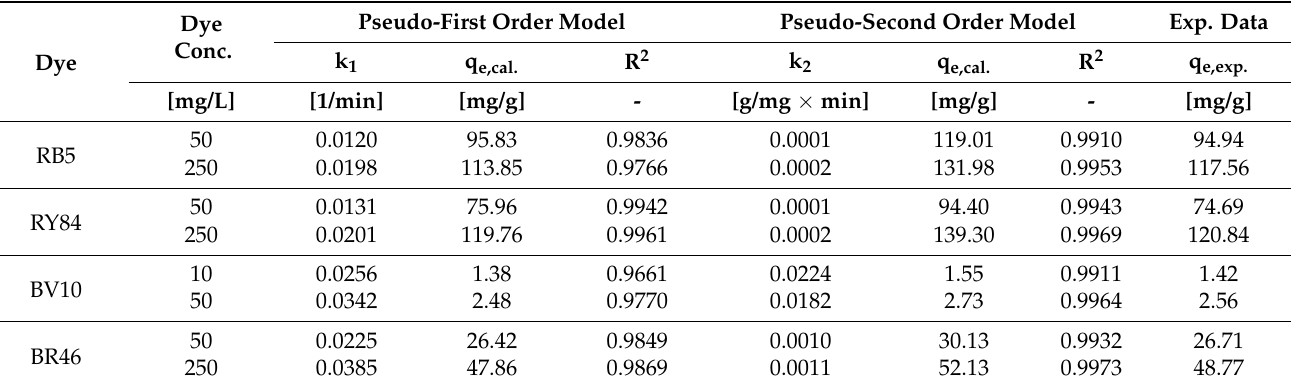
Table 2. Kinetic parameters of sorption of dyes onto CHM determined from the pseudo-first order and pseudo-second order